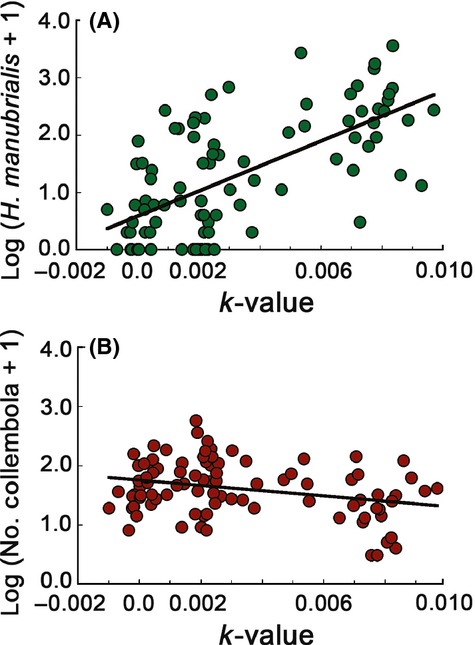
Numbers of animals per litter cage (LN (x +1)-transformed) as a function of litter decomposition rate in the same cage (abundance [k-values from Bengtsson et al. 2011], at time = 1 and time = 2 combined). (a) = Hypogastrura manubrialis and (b) = all indigenous species combined. Regression lines: H. manubrialis: y = 218.02x + 0.5846; R2 = 0.4275; P < 0.0001. Indigenous species: y = −44.315x + 1.7484, R2 = 0.0879; P = 0.0041. The slopes of the two relations differ significantly (significant interaction between k-value and taxa in ANCOVA).